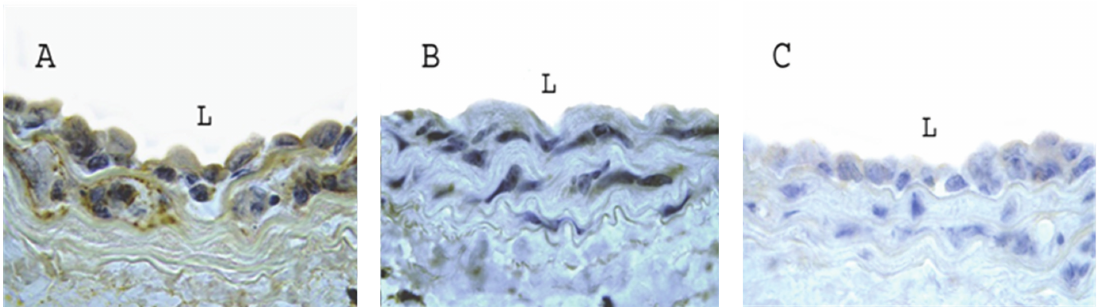
Figure 2: Representative pictures of BrdU-positive cells in carotid arteries from PPAR α knockout mouse, WT mouse, and WT mouse treated with Wy14643 at day 4 after injury (100x). (A) PPAR α knockout group; (B) WT group; (C) WT group treated with Wy14643. BrdU-positive cells were much more in the PPAR α knockout group when compared to WT group. PPAR α activation further decreased BrdU-positive cells.